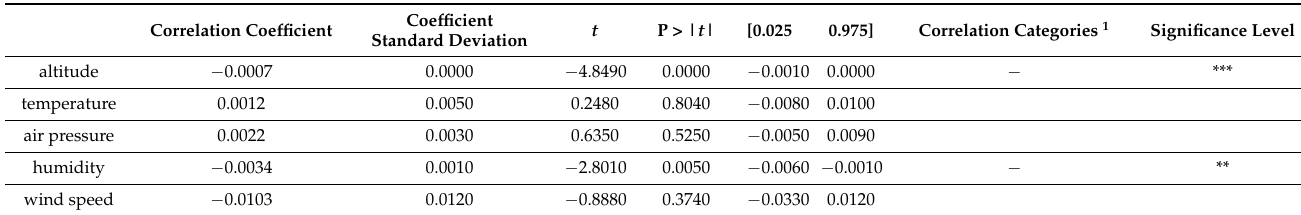
Table 5. The correlation performance of each feature when the dependent variable is average paddle frequency difference of Q2–Q3.